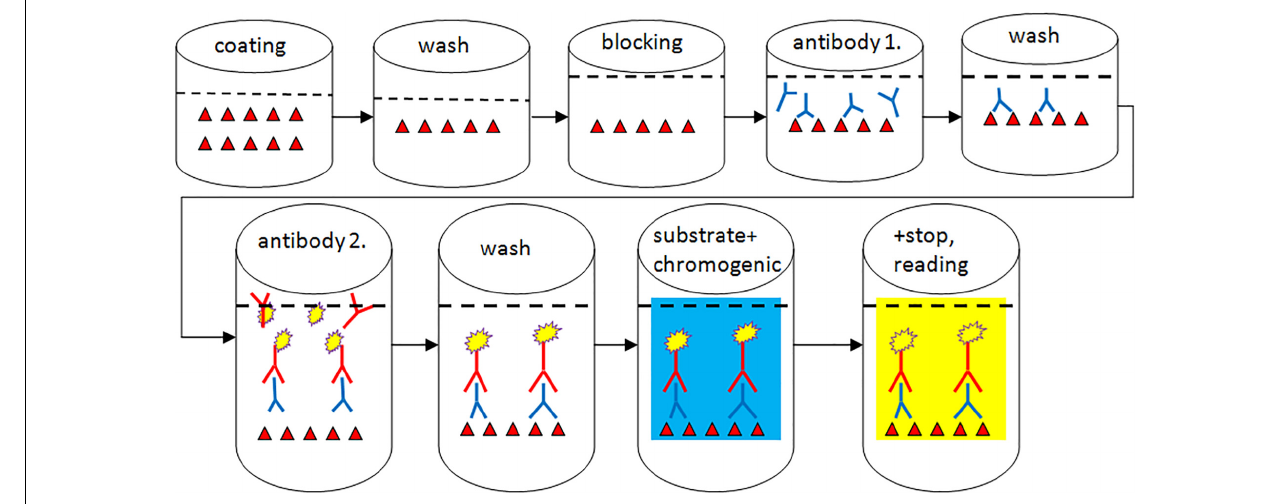
FIGURE 3 | Structure of a competitive